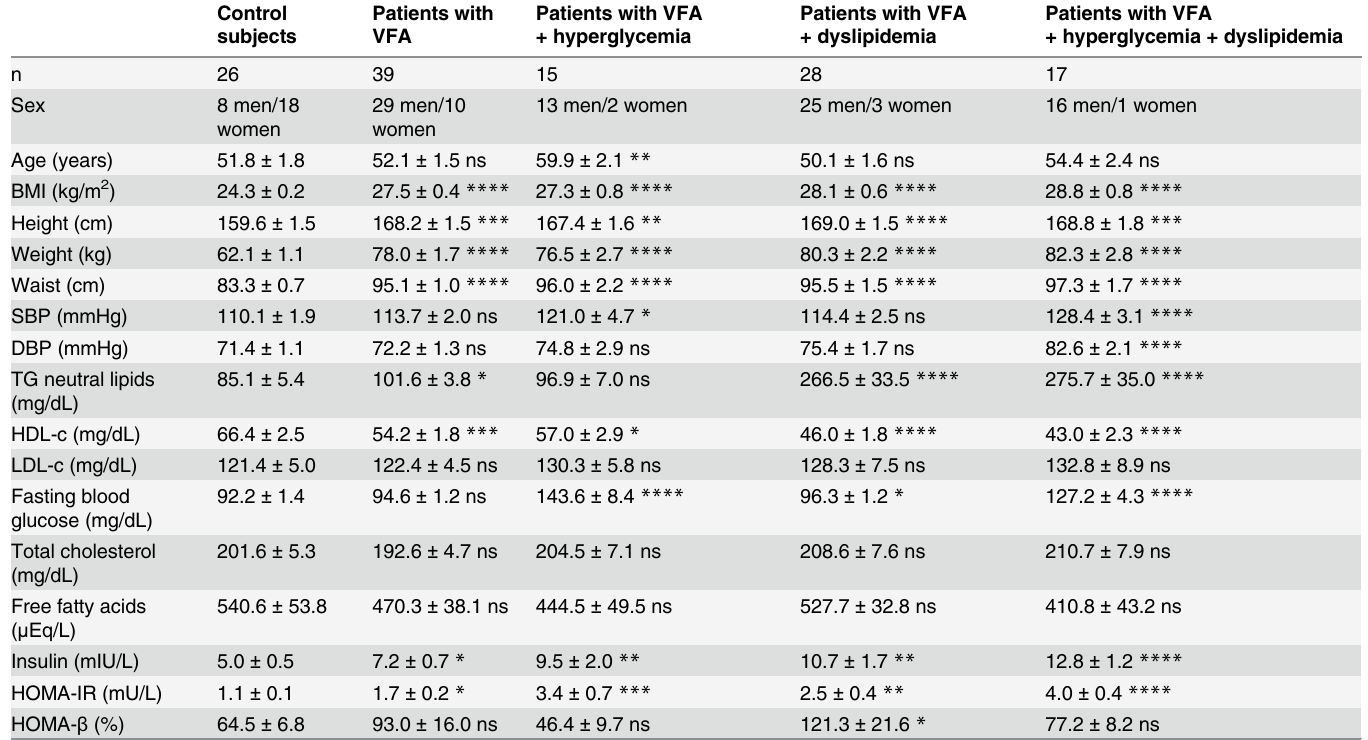
Table 1. Subject Characteristics.